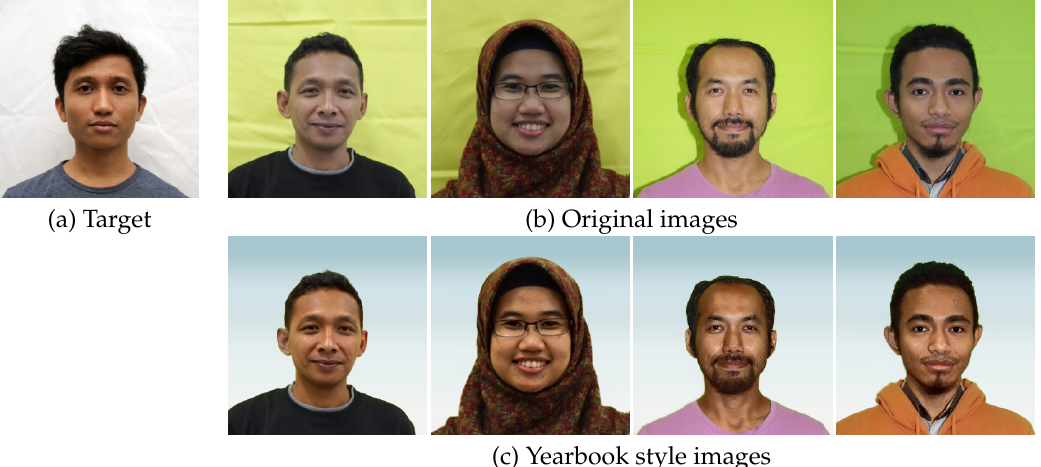
Figure 10. Results of automatic yearbook style photo generation using our method. ( a ) target facial skin color image; ( b ) original images which have a background color similar to the facial skin color; ( c ) yearbook style images using our